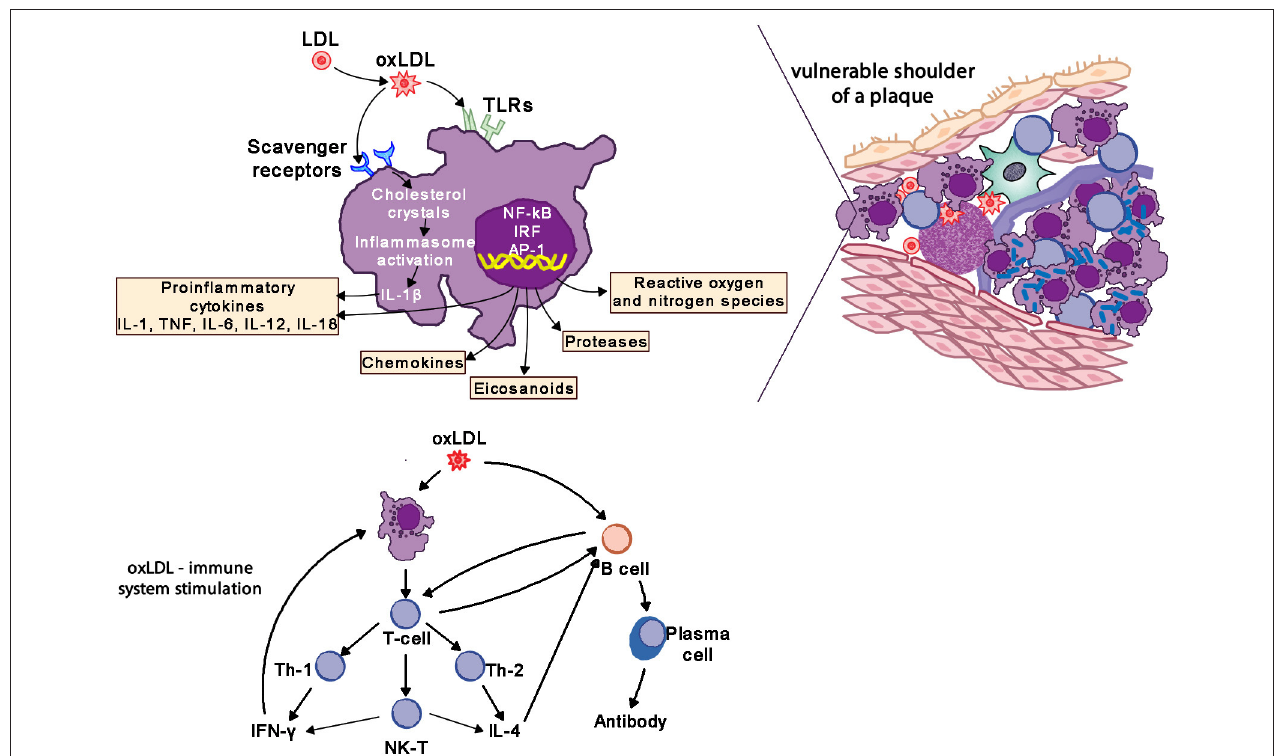
FIGURE 8 | Oxidized LDL (oxLDL) activates pro-inflammatory pathways to drive inflammatory changes in coronary vascular disease. LDL, low-density liporptein; oxLDL, oxidized LDL; TLR, toll-like receptors; IL-1, interleukin-1; IL-6, interleukin-6; IL-12, interleukin-12; IL-18, interleukin-18; TNF, tumor necrosis factor; IL-4, interleukin-4; IFN- γ ,